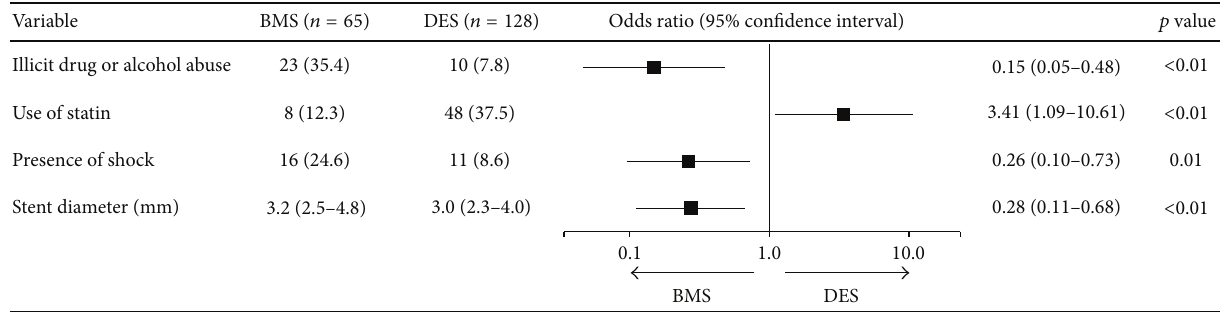
Figure 2: Multivariate logistic regression of factors associated with DES or BMS. Independent predictors of BMS use include the presence of shock, illicit drug or alcohol abuse, and larger culprit coronary artery